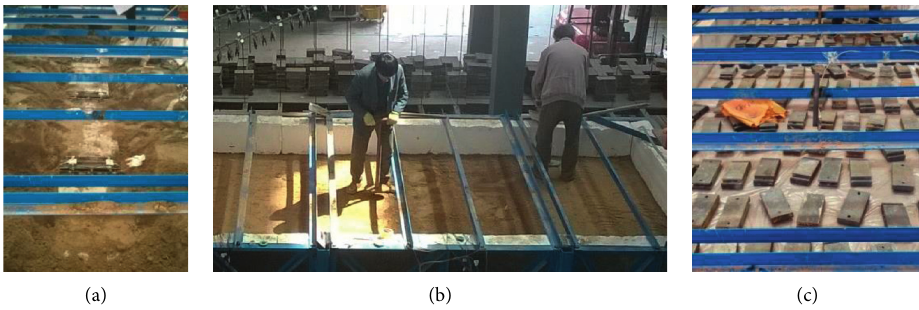
Figure 7: Model installation (a) Placed tunnel; scratching; (b) Tamping; (c)